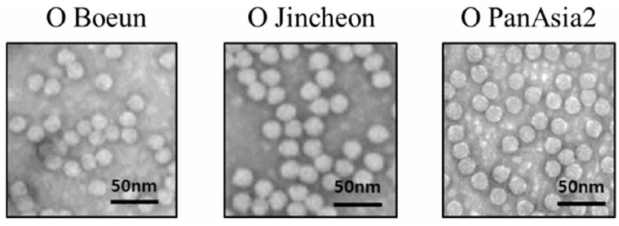
Figure 3. Morphological observation on a transmission electron microscope. The heparin a ffi nity column purified serotype O foot-and-mouth disease viruses were negatively stained and analyzed for morphology. The bars represent 50